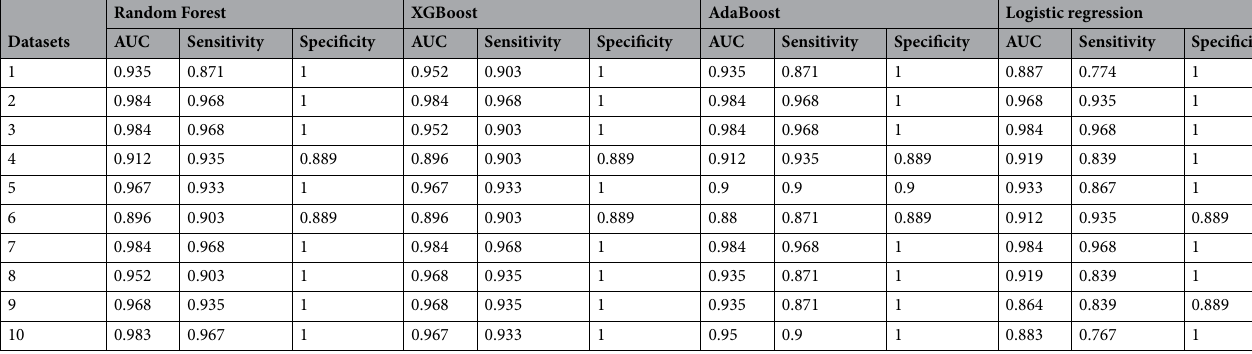
Table 3. Comparison of ML model accuracy to diagnose